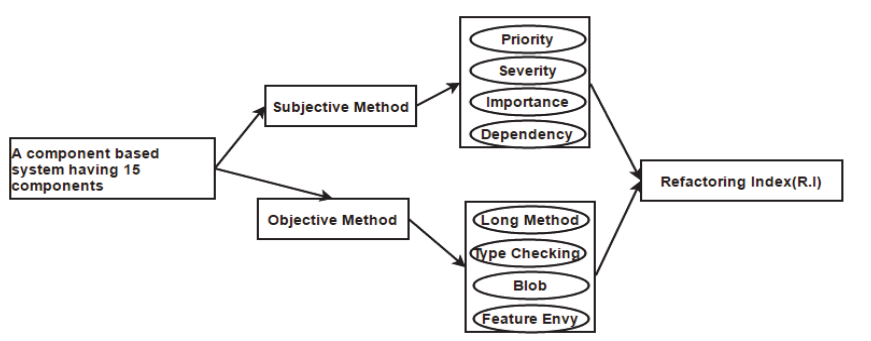
Fig. 3. Framework for combined approach